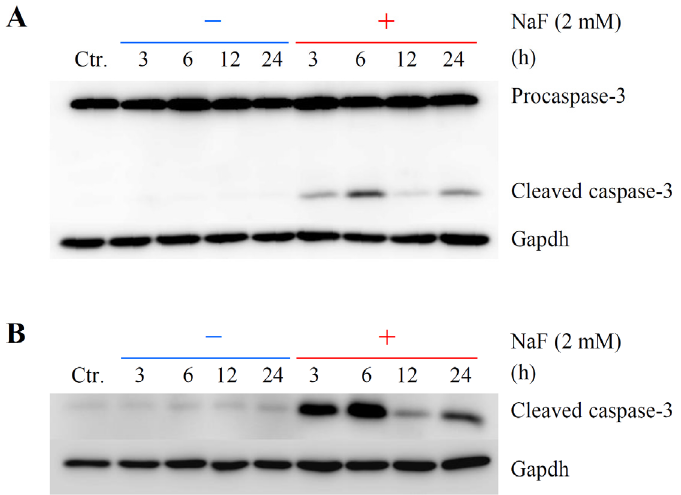
Figure 4. Effects of NaF on caspase-3 cleavage in ROE2 cells. Cells were cultured with or without 2 mM of NaF for 3 to 24 h. Western blot analysis was performed with anti-caspase-3 antibody, which reacted with procaspase-3 and cleaved caspase-3 ( A ); anti-cleaved caspase-3 antibody ( B ) and anti-Gapdh antibody. Gapdh served as a loading control. Ctr., control.